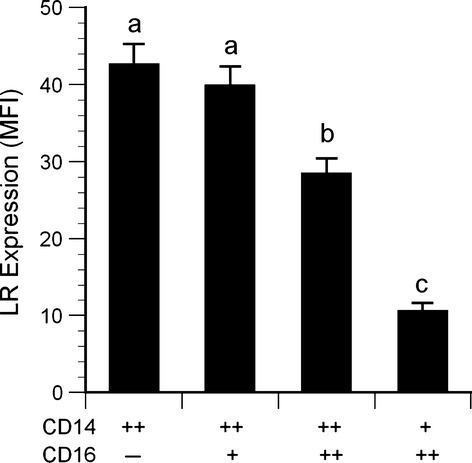
Native leptin receptor expression on monocytes. Data for each monocyte subtype are expressed as median fluorescence intensity minus isotype control fluorescence. (n = 34). Statistical key: a > b > c, all pairwise comparisons P < 0.002.